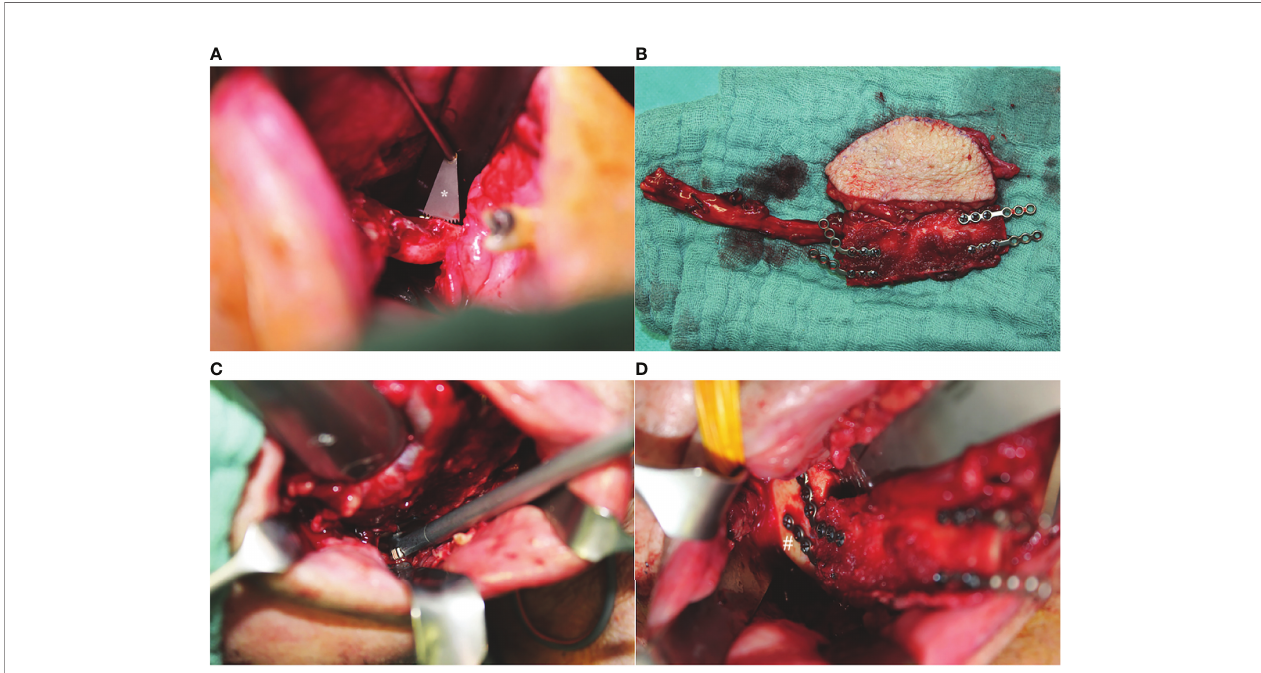
FIGURE 2 | Intraoperative situations with angulated instruments for pure intraoral mandibular resection and osteosynthesis of a one-segmented osteomyocutaneous fi bula free fl ap: (A) mandibular osteotomy with an angulated microsaw (*) with an integrated rinsing system (Medicon; Tuttlingen, Germany), (B) one-segmented osteomyocutaneous fi bula free fl ap with pre-bent 2.0 mini-plates, (C) 90° angulated drill and screwdriver (Modus ® 2 90° Luhr Fritzmeier screwdriver; Medartis AG; Basel, Switzerland) for osteosynthesis at the right mandibular angle, and (D) intraoperative reconstructive result after completed osteosynthesis with monocortical screws at the right mandibular angle (#).